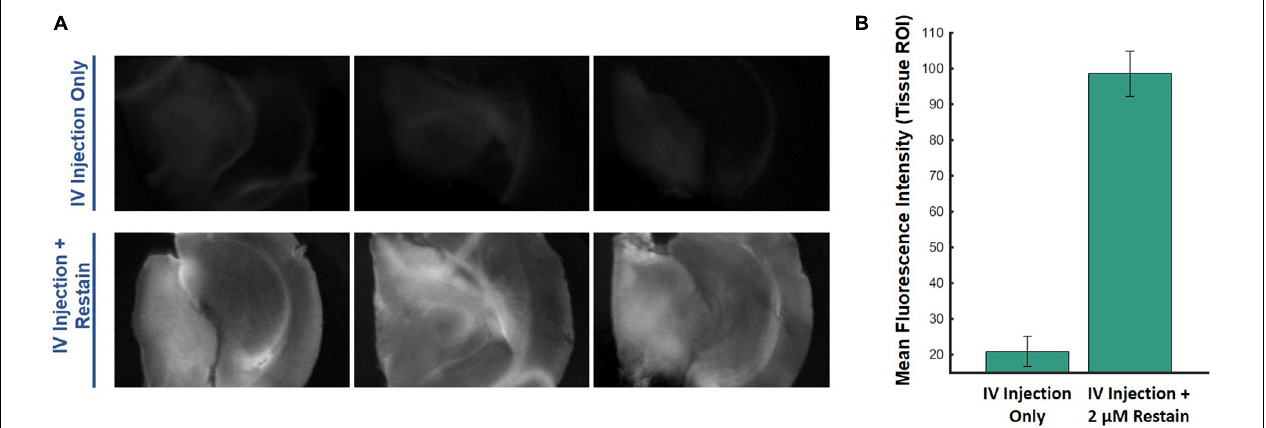
FIGURE 6 | Ex vivo comparisons of (A) brain slices imaged from the same mouse injected intravenously with VSD at baseline (no stimulation) without (top) and with (bottom) re-staining using 2- µ M medium, showing (B) significantly greater fluorescence signal with the re-staining process, which indicates that IV VSD injection delivered less than 2 µ M of VSD to the visual cortex tissue.